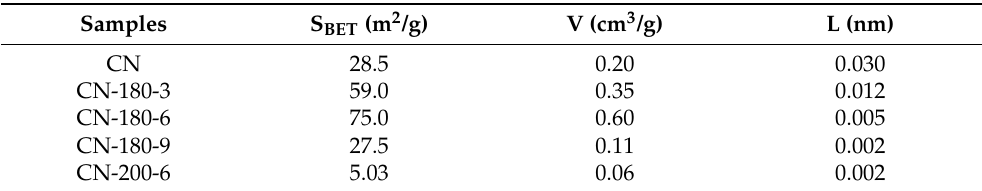
Table 1. Specific surface area, pore volume, and average pore size of photocatalysts were determined via N 2 adsorption-desorption isotherm measurements.